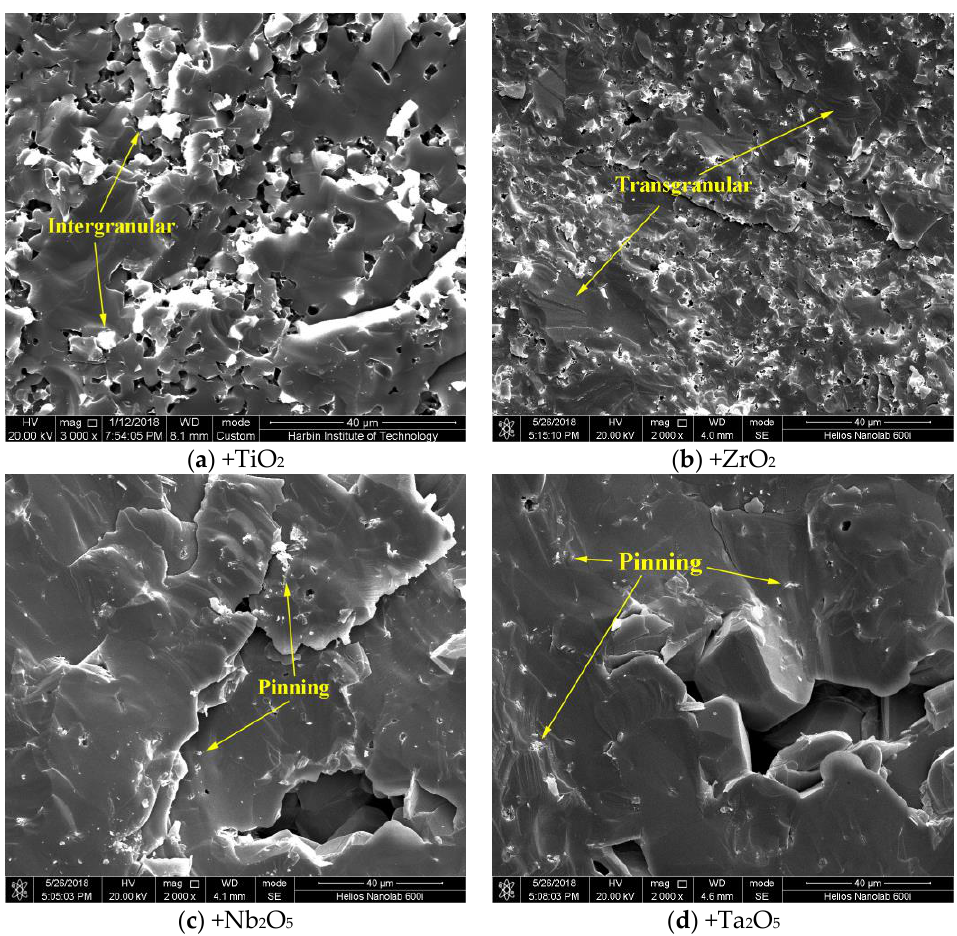
Figure 4. The results of SEM analysis of sintered samples and the fracture surfaces of final products: ( a ) +TiO 2 ; ( b ) +ZrO 2 ; ( c ) +Nb 2 O 5 ; ( d ) +Ta 2 O 5 .